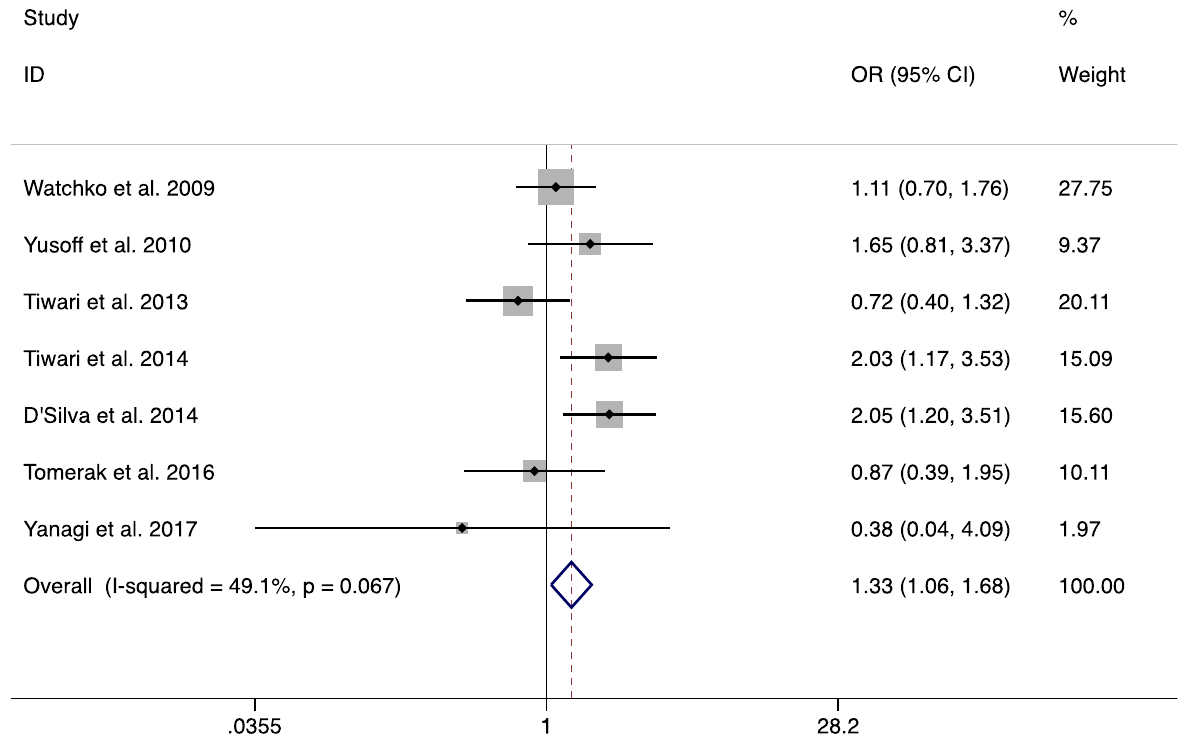
Fig. 3 Fixed-effects meta-analysis on NNH risk and c.-3279T>G (rs4124874) polymorphism under GT+GG vs TT in overall population (GT+GG vs